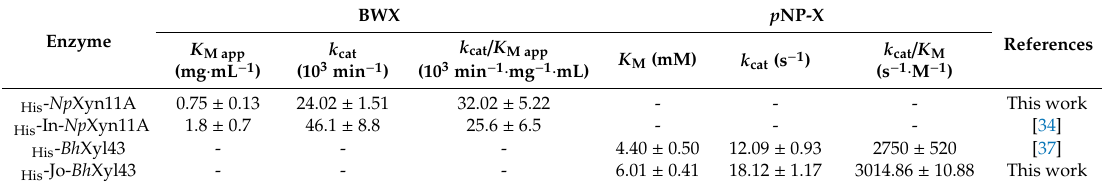
Table 1. Kinetic parameters of Np Xyn11A, Bh Xyl43 and the Jo In derivate enzymes on